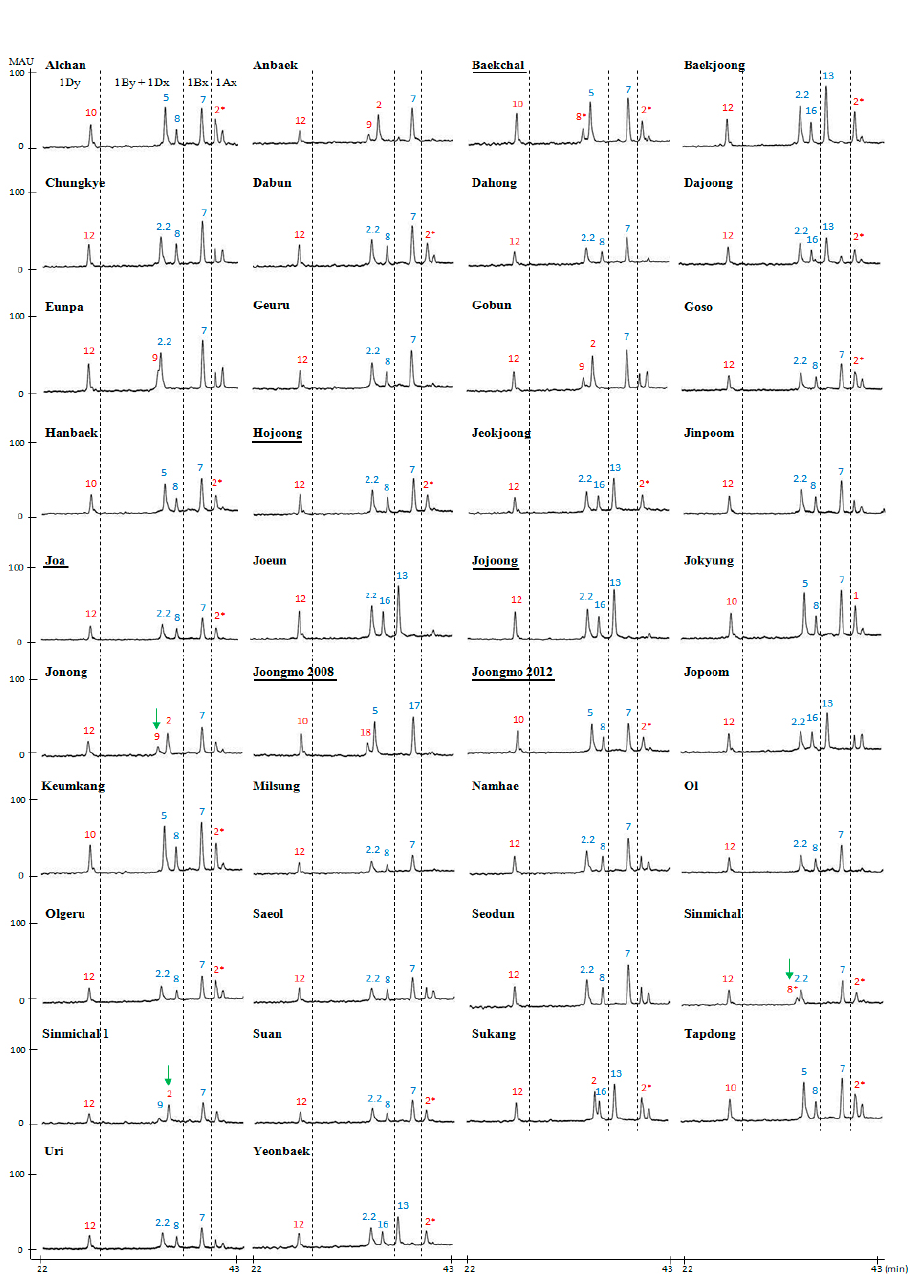
Figure 4. HMW-GS profiles of 38 Korean wheat cultivars determined by RP-HPLC. Subunits that could not be distinguished unequivocally by RT are indicated in red. Their identities were confirmed by SDS-PAGE. Arrows denote subunits that were incorrectly identified in previous SDS-PAGE analyses. Names of new cultivars that were not analyzed previously by SDS-PAGE are underlined.